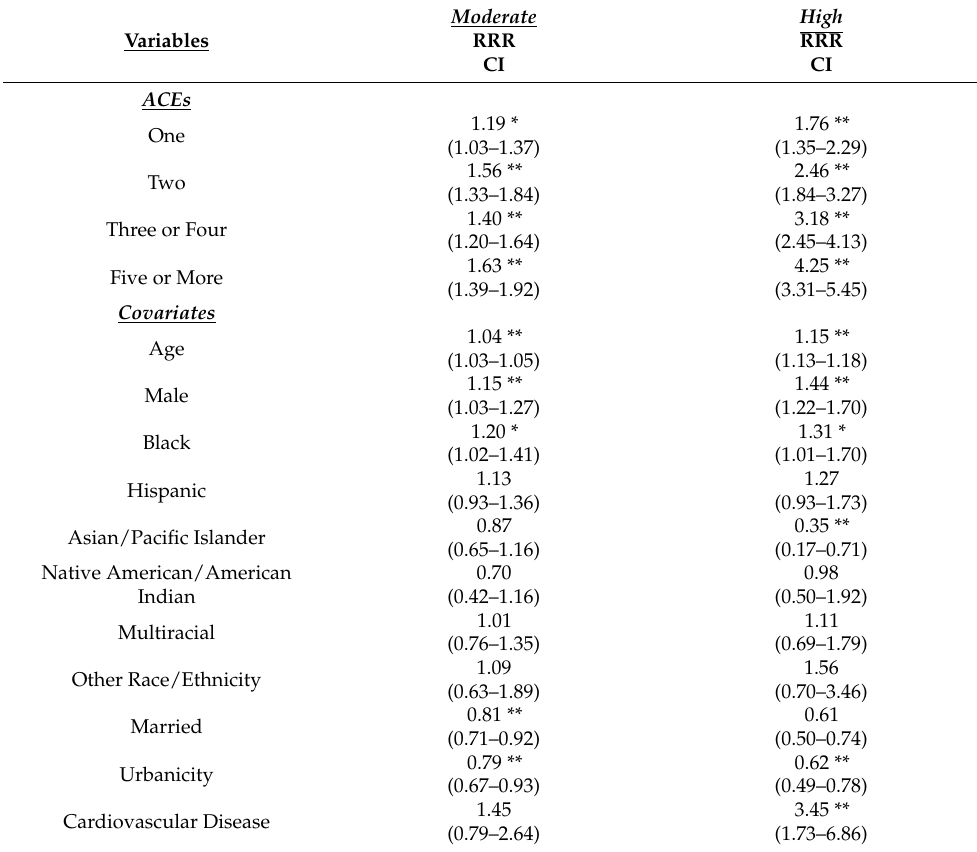
Table A4. Multinomial logistic regression models of the association between ACEs and cardiovascular risk among young adults aged 18–34 years, including those with a history of cardiovascular disease ( n = 14,425).